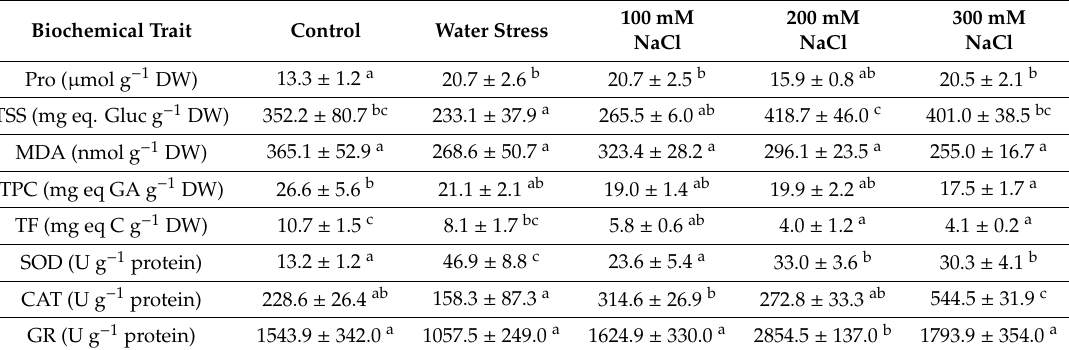
Table 5. Leaf concentrations of proline (Pro) and total soluble sugars (TSS), malondialdehyde (MDA), total phenolics (TPC) and total flavonoids (TF), and specific activities of antioxidant enzymes, superoxide dismutase (SOD), catalase (CAT) and glutathione reductase (GR), after 23 days of stress treatments of Thalictrum maritimum plants grown in controlled conditions in the greenhouse. Values shown are means ± SE ( n = 5). Same lowercase letters in each row indicate homogeneous groups between treatments according to the Tukey test ( p ≤